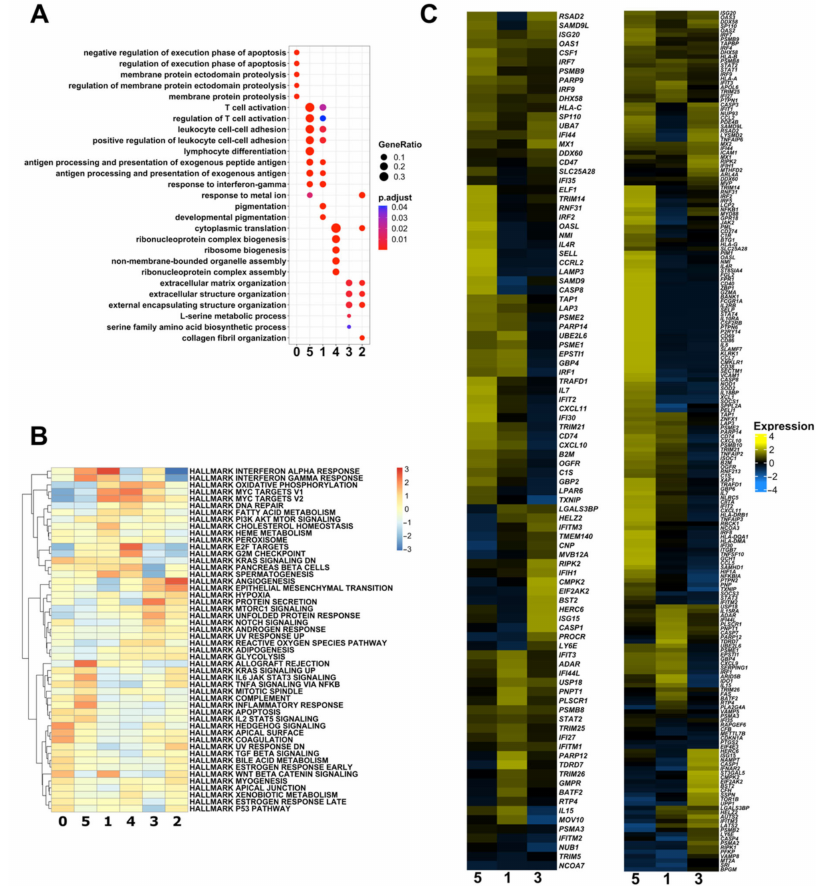
Figure 2. Melanoma cell clusters show unique characterization. ( A ) Dot plot representing the GO enrichment (biological process) for the DEGs of each melanoma cell cluster. ( B ) Heatmap visualization for the Hallmark GSEA in the melanoma cell clusters. ( C ) Heatmaps showing the expression levels of genes derived from HALLMARK_INTERFERON_ALPHA_RESPONSE gene set (left), and HALLMARK_INTERFERON_GAMMA_RESPONSE gene set